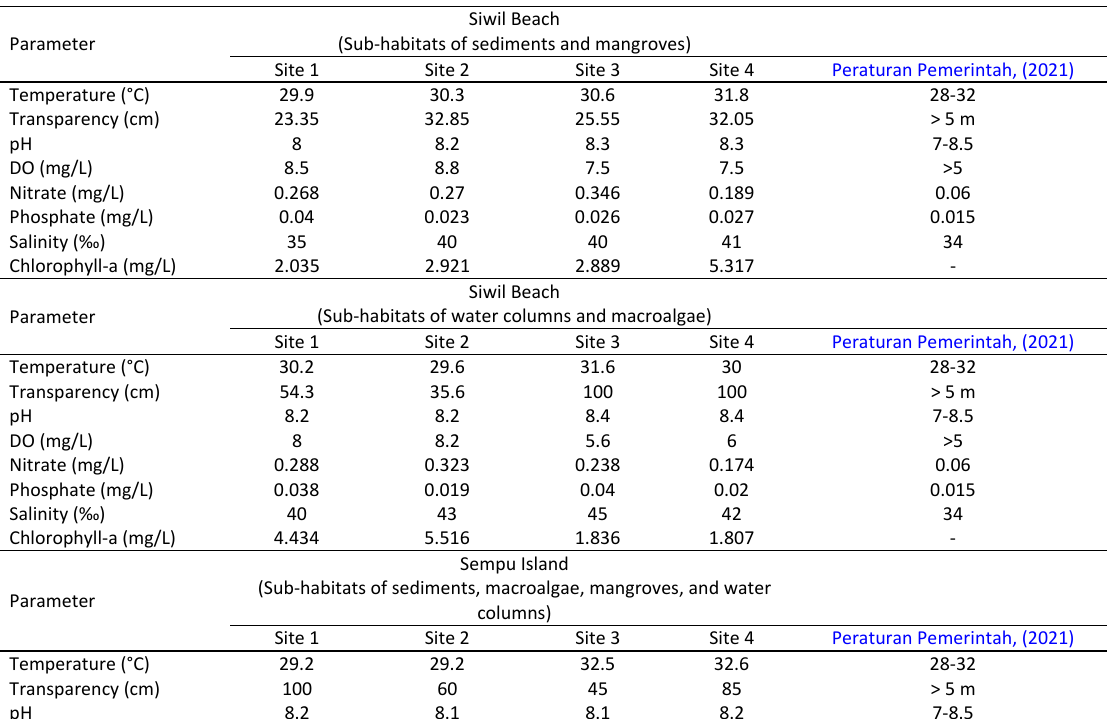
Table 1: Water quality measurement results